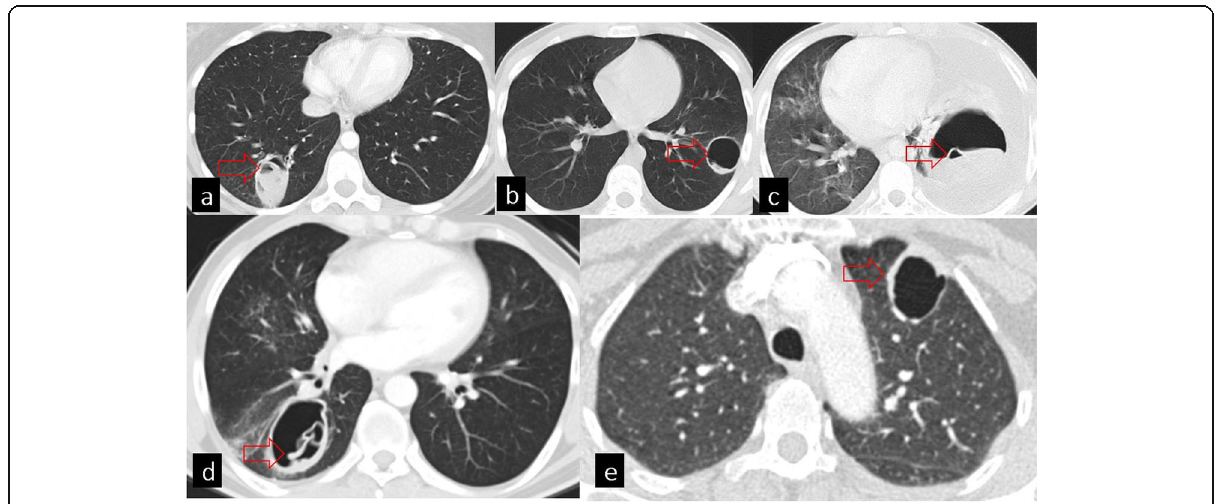
Fig. 6 Complete rupture signs. Axial CT images of different patients on the lung window ( a – e ). a Cumbo sign (red arrow). b Mass within cavity sign (red arrow). c Waterlily sign (red arrow). d Whirl sign (red arrow) e. Empty cyst sign (red